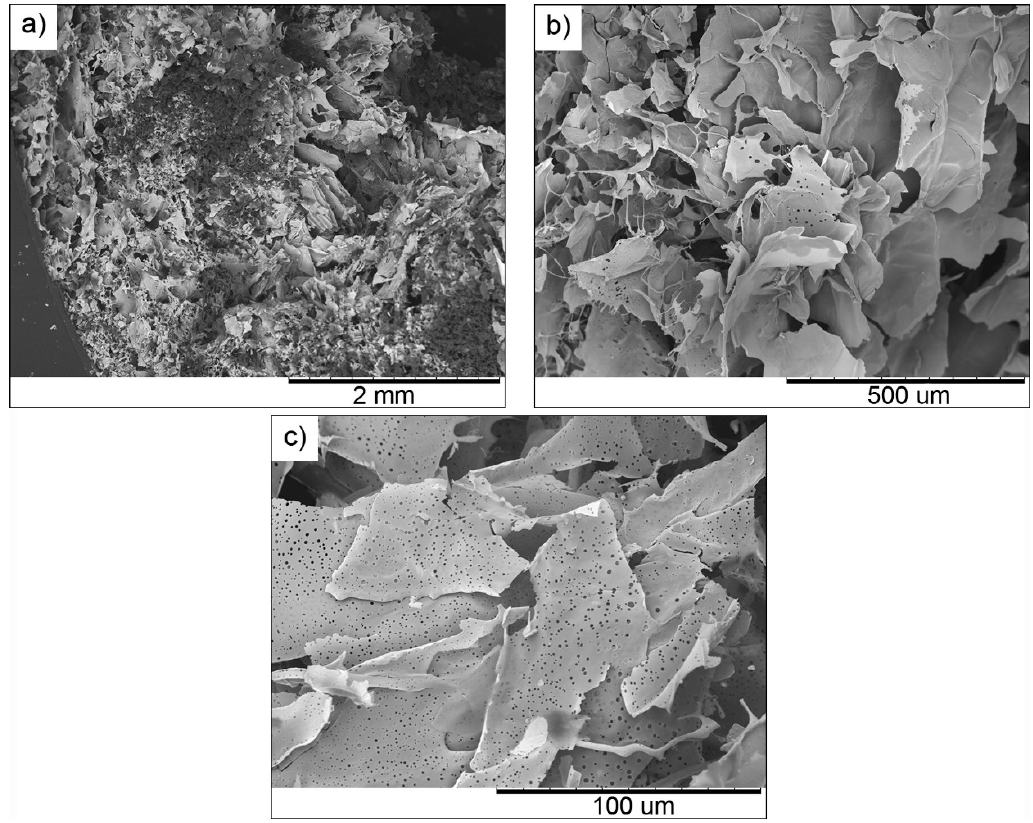
Figure 4. SEM images at different magnifications of the fragile fractured surface of sample C.